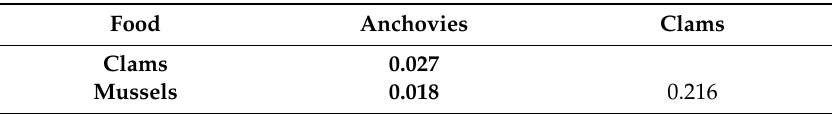
Table 3. Food preference test. Wilcoxon matched-pairs test significance p -value, p -values < 0.05 are marked in bold.